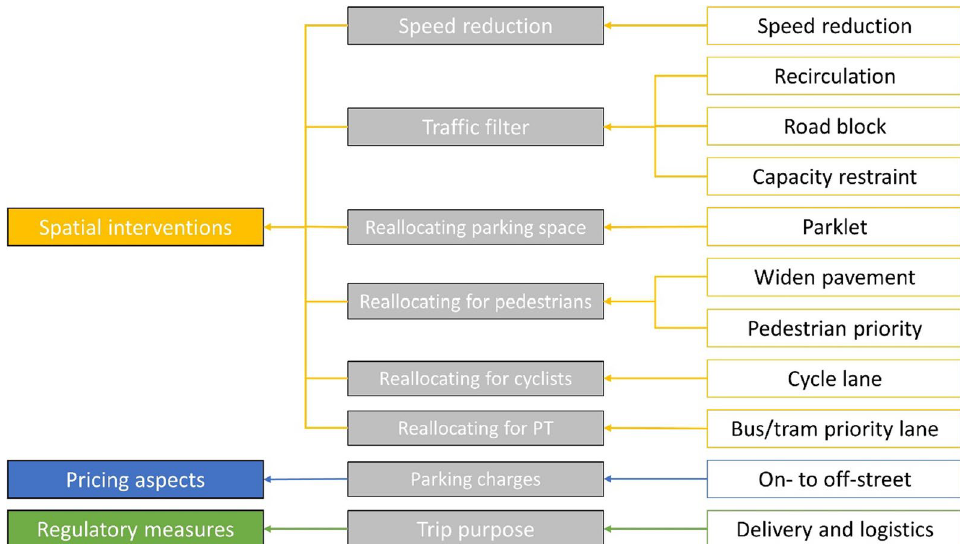
Fig. 10 Schematic representation of the UVAR taxonomy applied for the case study of Barcelona (implementation of a superblock